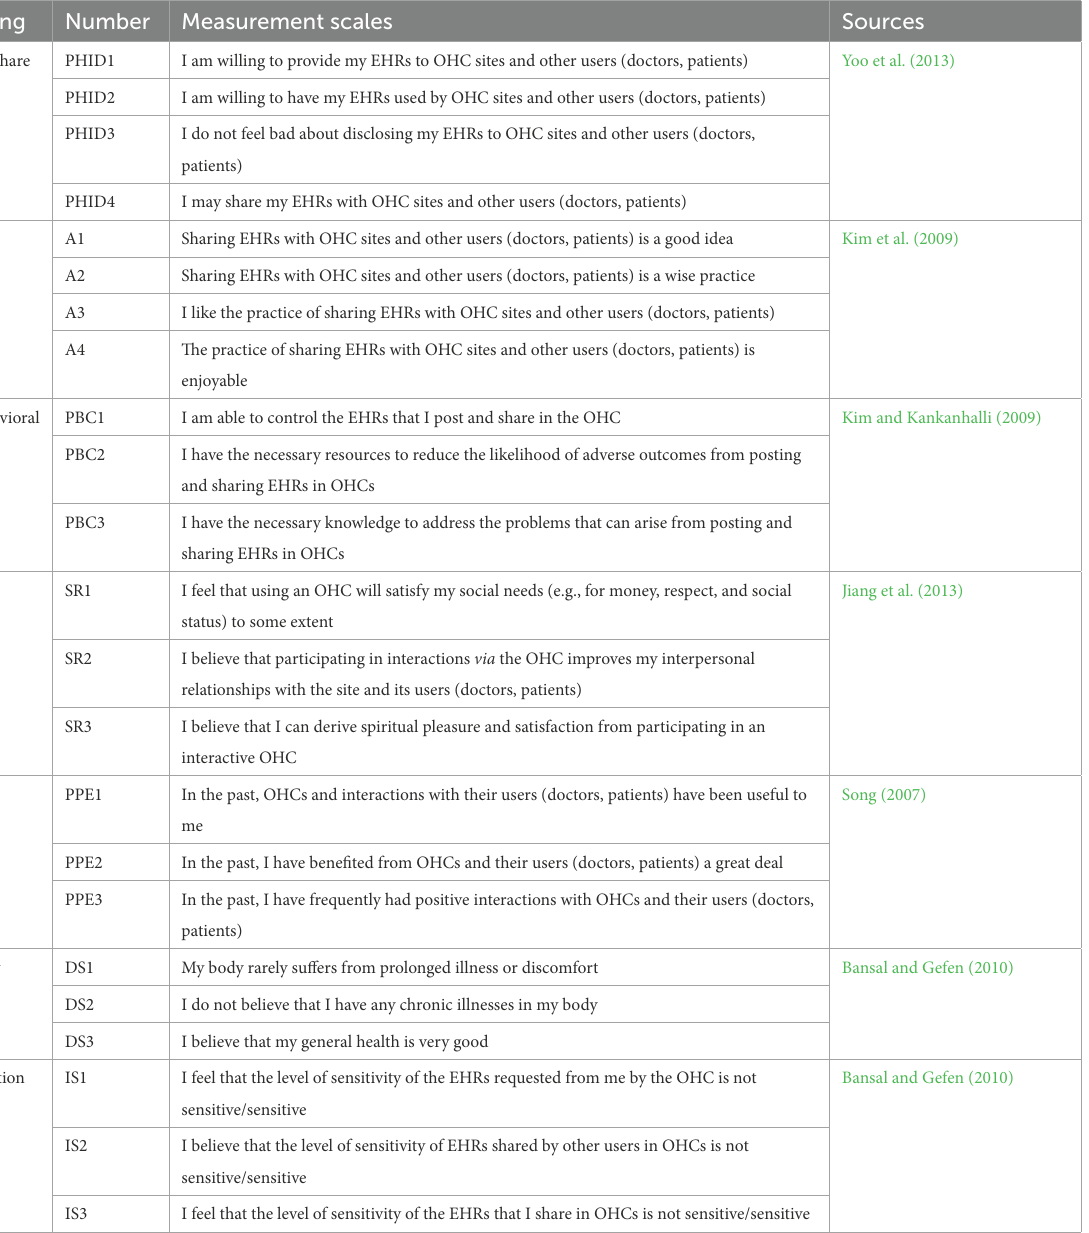
TABLE 1 Measurement